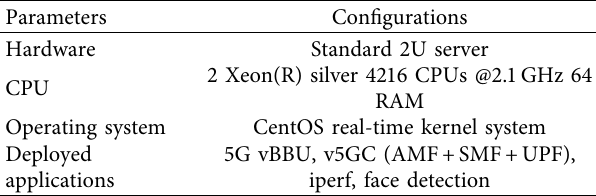
Table 2: Physical confgurations of the all-in-one server.